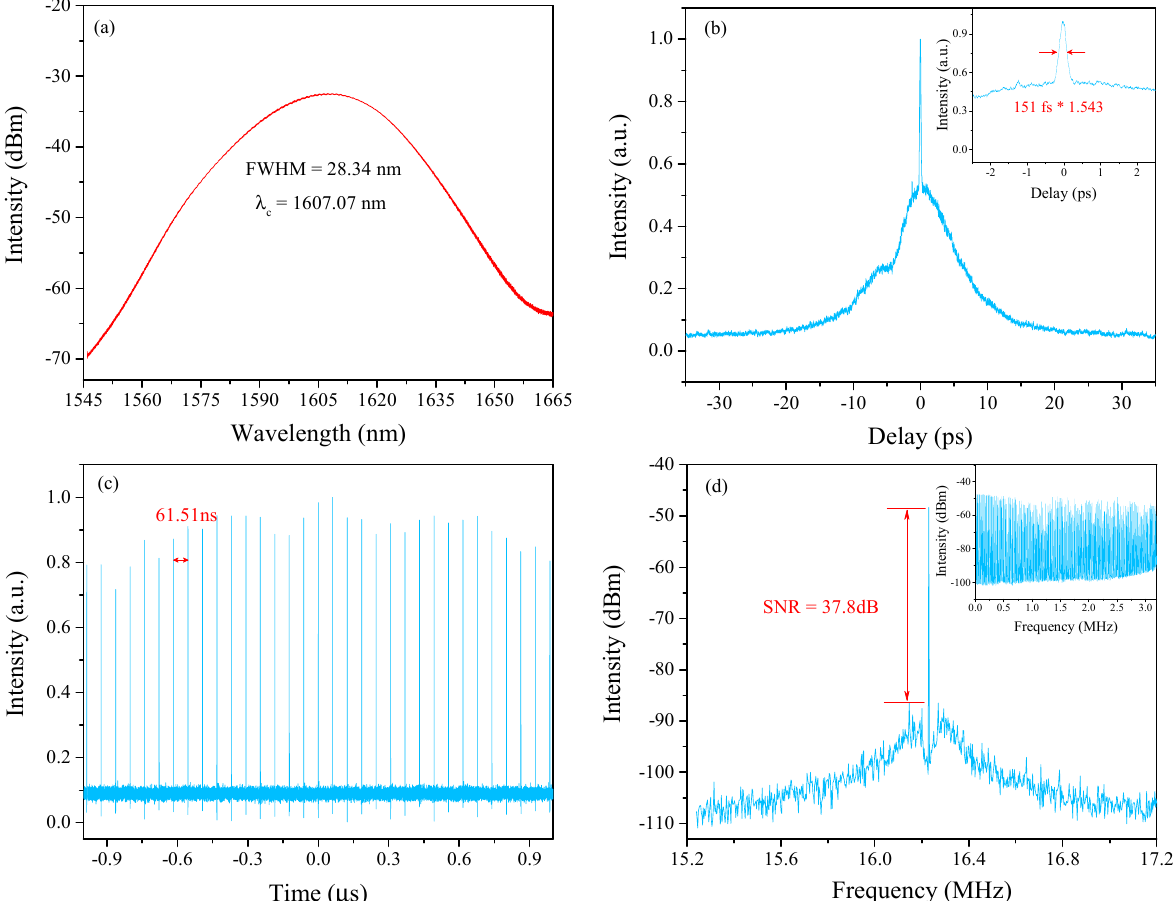
Figure 9. Measurement results of NLP. ( a ) Optical spectrum. ( b ) AC trace; the inset figure is the narrow spike. ( c ) Pulse train measured by oscilloscope. ( d ) RF spectrum with a span and resolution of 2 MHz and 300 Hz; the inset figure is the RF spectrum with a span and resolution of 3.2 GHz and 10 kHz.